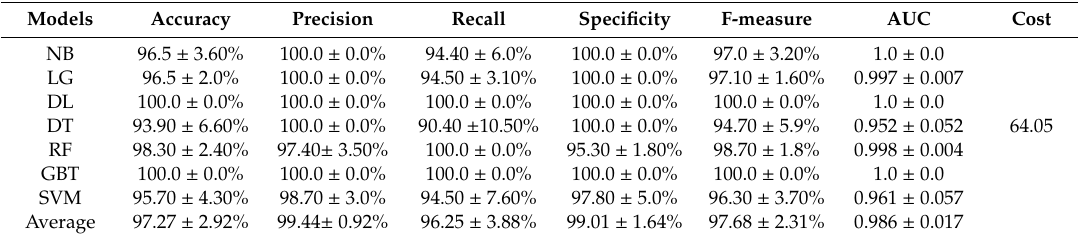
Table 13. Ensemble-2 results based on selected